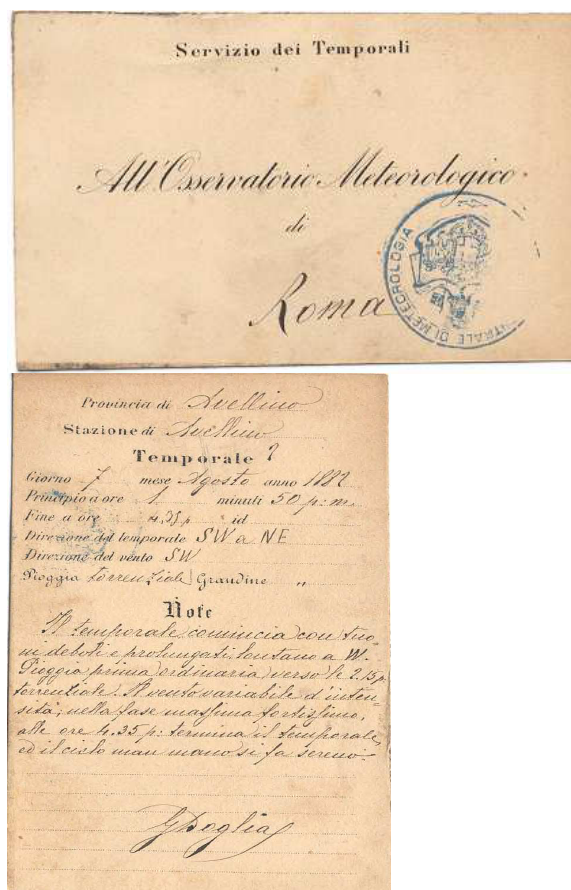
Fig. 4 Figure 4. Sample of a Thunderstorms postcard. Front: Thun- derstorms Service – Meteorological Observatory Rome. Back: Province Avellino, Station of Avellino, Thunderstorm of Day 7, Month August, Year 1882. Start at hours 1 minutes 50p.m. End at hours 04:35p.m., id = Thunderstorm direction SW To NE. Wind direction SW. Rain Torrential. Hail = Remarks: thunderstorm starts with weak and protracted thunders far at W. Rain at the first time regular, about at 02:15p.m. torrential. Wind of changeable inten- sity; in the maximum phase very strong. At 04:35p.m.: thunder- storm stops and sky gradually becomes clear. Signature not under- standable.